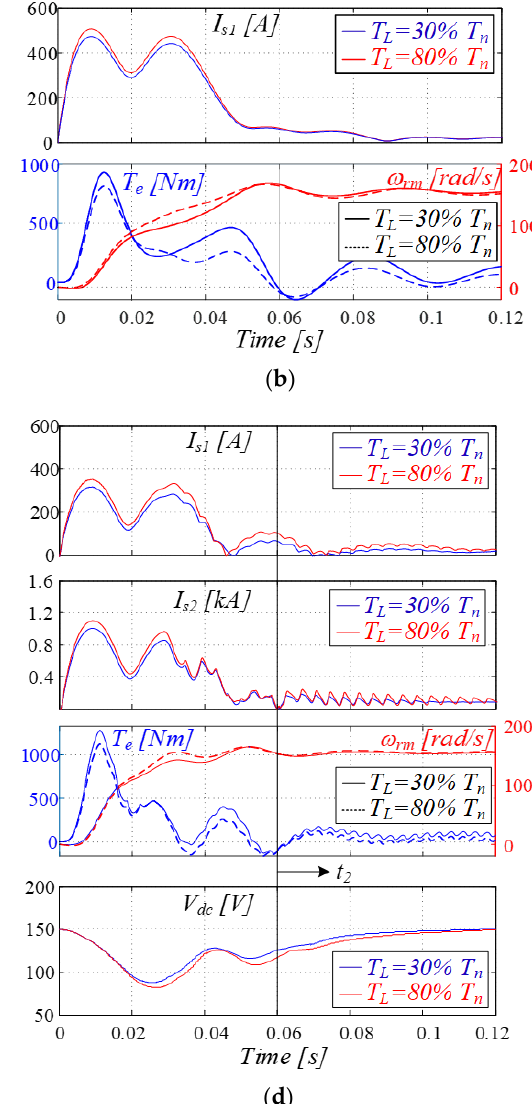
Figure 15. Harmonic content of motor quantities with and without harmonic compensation when a 5th harmonic compo- nent is superimposed on the AC grid voltage: ( a ) main winding phase stator amplitude voltage V as1 , auxiliary winding phase stator voltage amplitude V as2 , main winding phase stator amplitude current I as1 , auxiliary winding phase stator amplitude current I as2 ; ( b ) qd-axes main winding stator current I qs1 and I ds1 , electromagnetic torque T e , mechanical speed  rm .